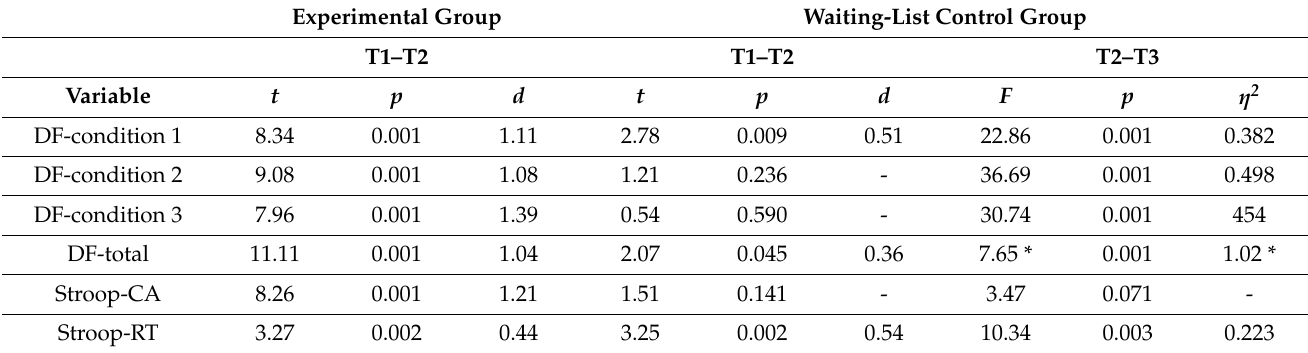
Table 3. Univariate pre- to post-test comparisons separately for the experimental and the waiting-list control group, for the design fluency and Stroop test